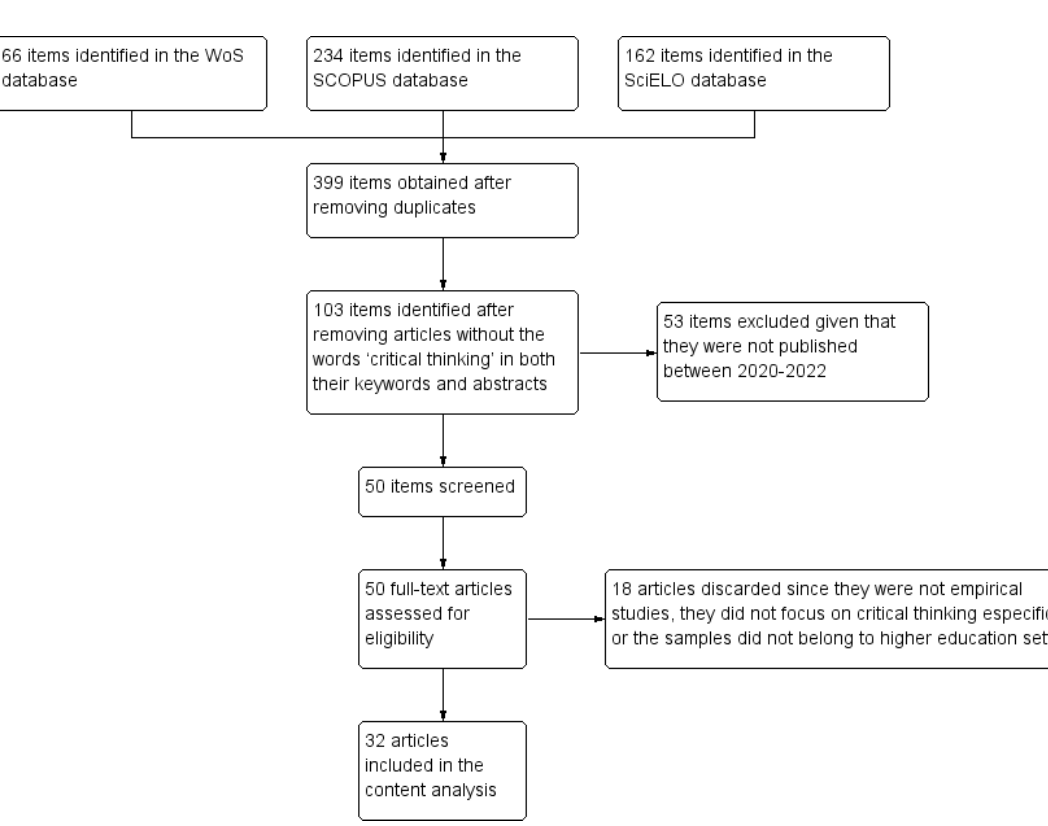
Figure 1. Flow diagram following the PRISMA